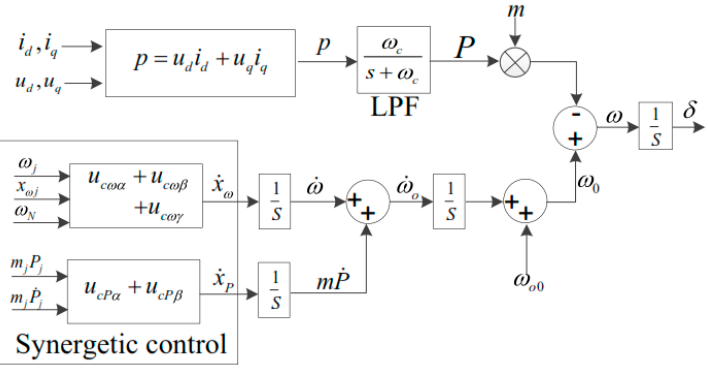
Figure 7. Diagram of the adaptive frequency droop control.